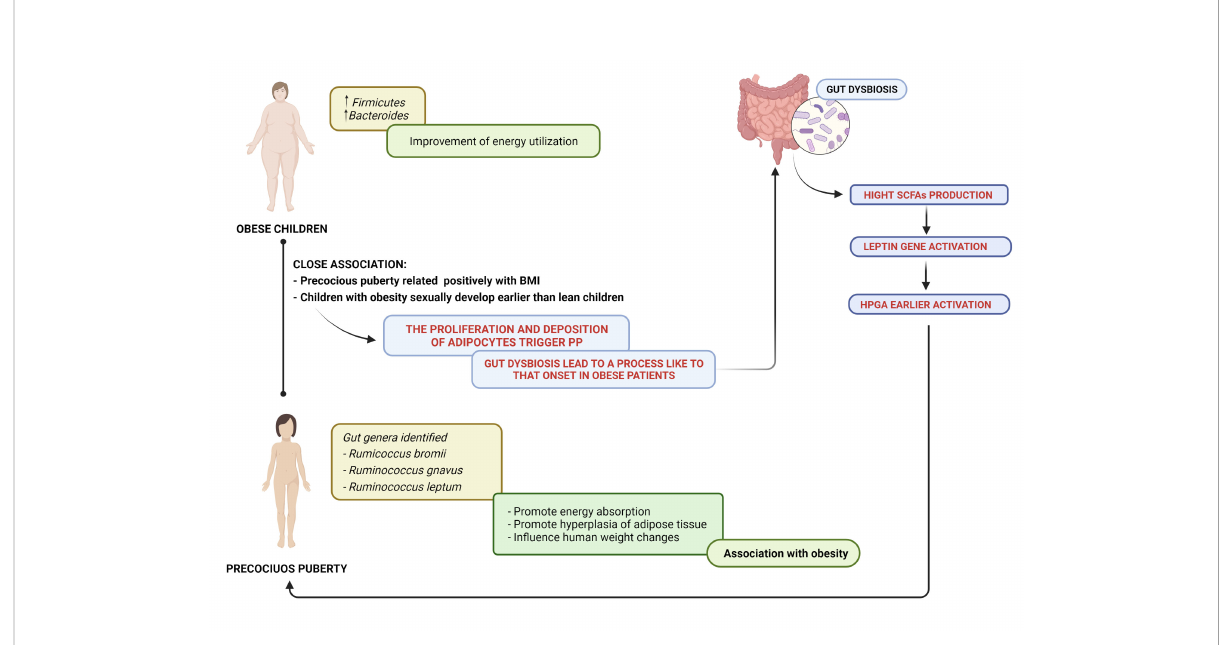
FIGURE 2 Precocious puberty – gut microbiome and obesity: a close association. SCFAs, short-chain fatty acids; HPGA, hypothalamic – pituitary – gonadal